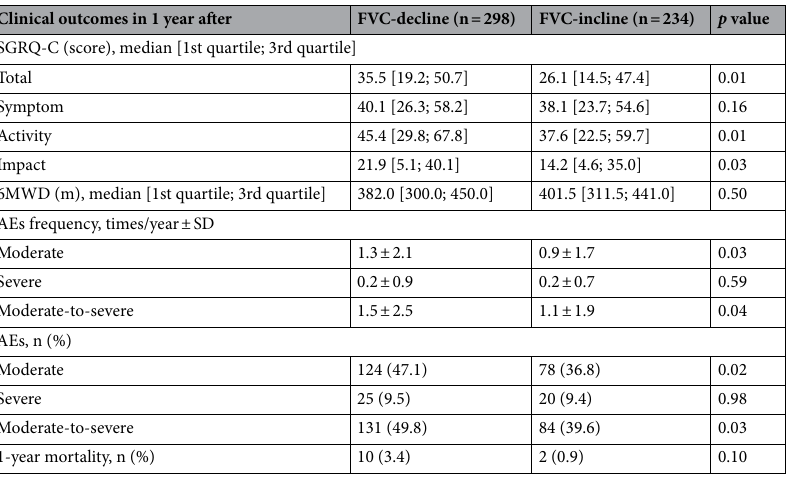
Table 2. Difference of clinical outcomes in one year after according to the FVC grouping. Clinical outcomes of one year after were compared between FVC-decline group and FVC-incline group. SGRQ-C total scores were significantly higher in FVC-decline group than in FVC-incline group. Those were similar in SGRQ-C activity and impact scores. Annual frequency of moderate and moderate-to-severe exacerbations were significantly higher in FVC-decline group than in FVC-incline group. Percentage of the patients who have exacerbation for one year showed similar results. AEs acute exacerbations, Δ annual changes of the postbronchodilator values, FVC forced vital capacity, SD standard deviation, SGRQ-C St. George’s Respiratory Questionnaire-Chronic obstructive pulmonary disease specific version, 6MWD 6-min walking